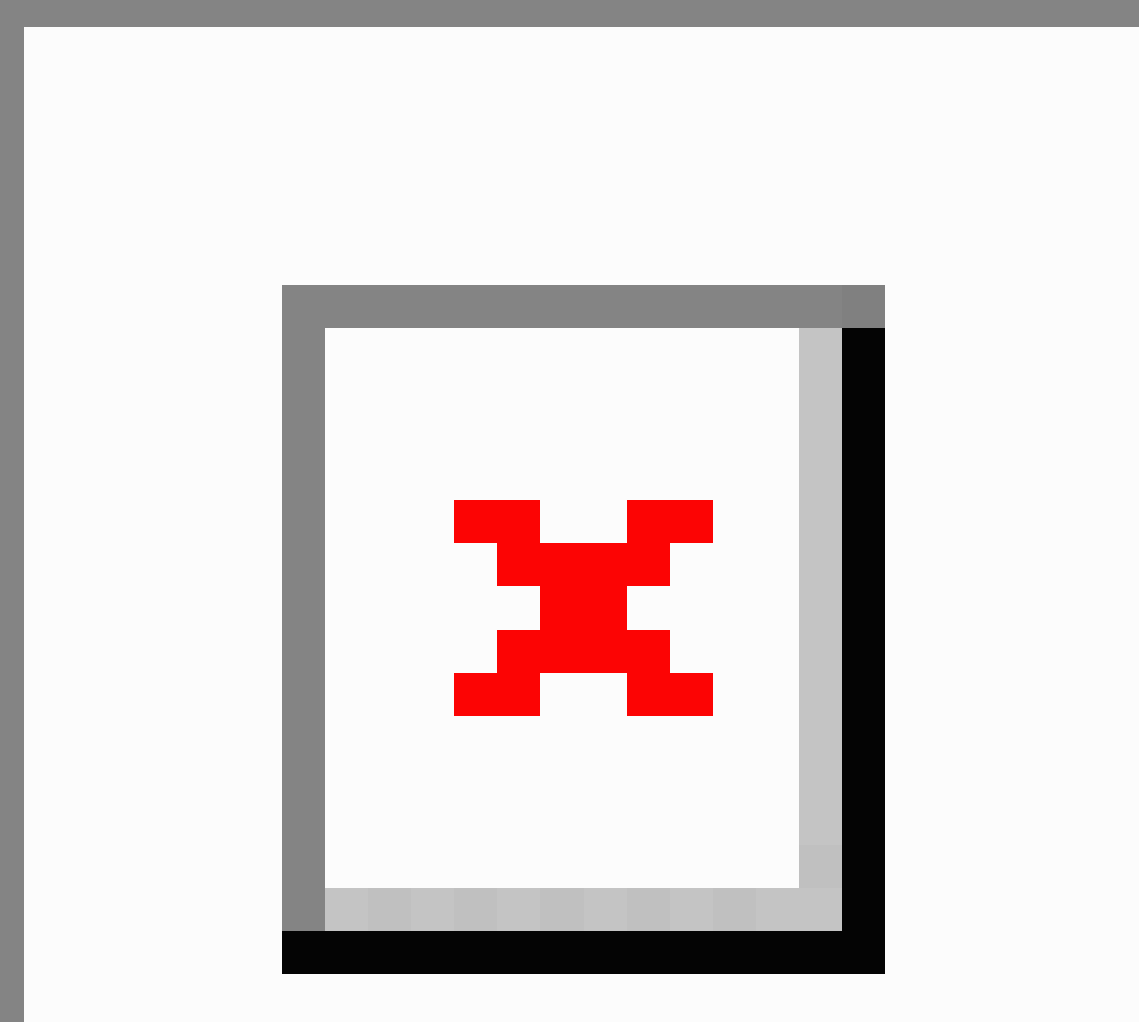
Figure 1. Search results for “Deep Vein Thrombosis” on the federated search platform. At the time of the study, the platform queried Wikipedia (top, left), PubMed (“diagnosis” category; top, right), the Cochrane library (bottom, left), and YouTube (bottom,